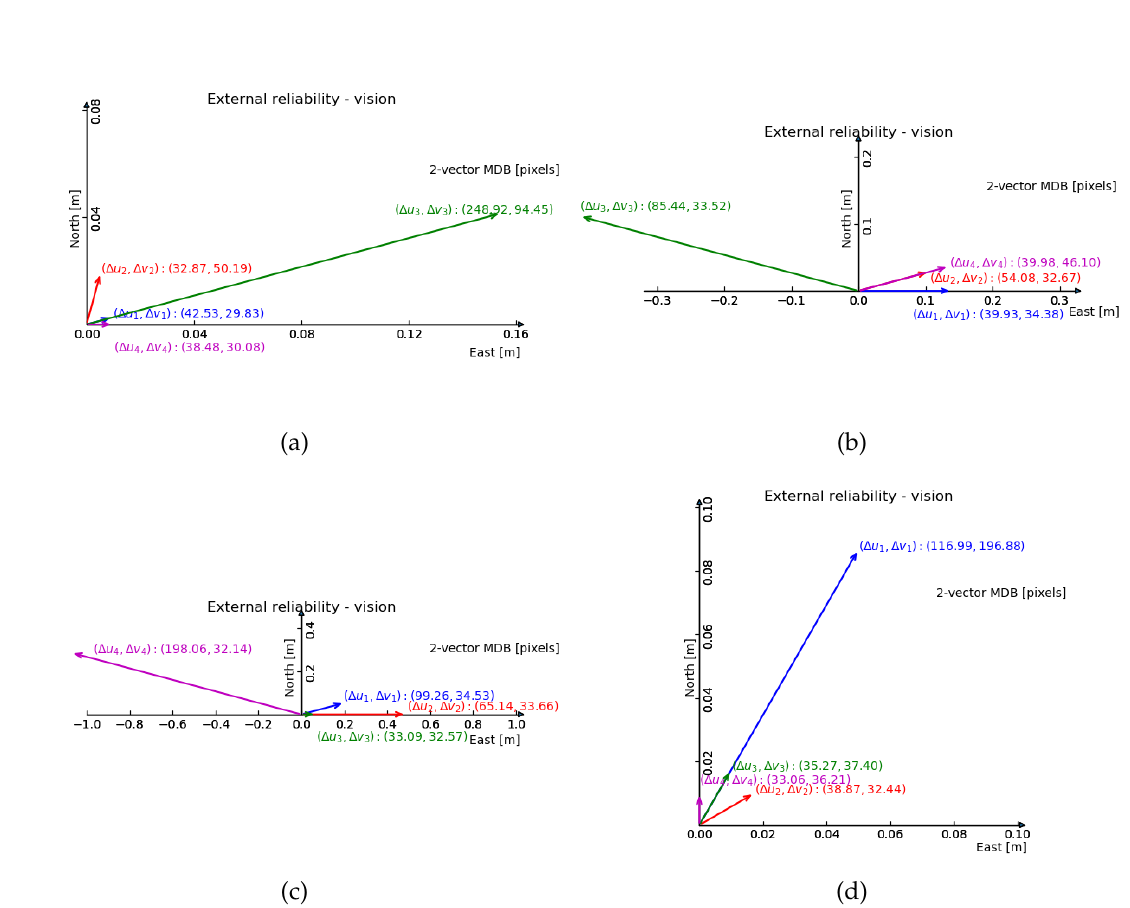
Figure 7. 2-fault external reliability computed by 4 features in 4 geometries in [m], the bias vector with largest magnitude is shown (in terms of horizontal position), and the corresponding internal reliability values are given between brackets. ( a ) Normal geometry; ( b ) Cluster; ( c ) Line up in x direction; ( d ) Line up in y direction. Scaling is different for each